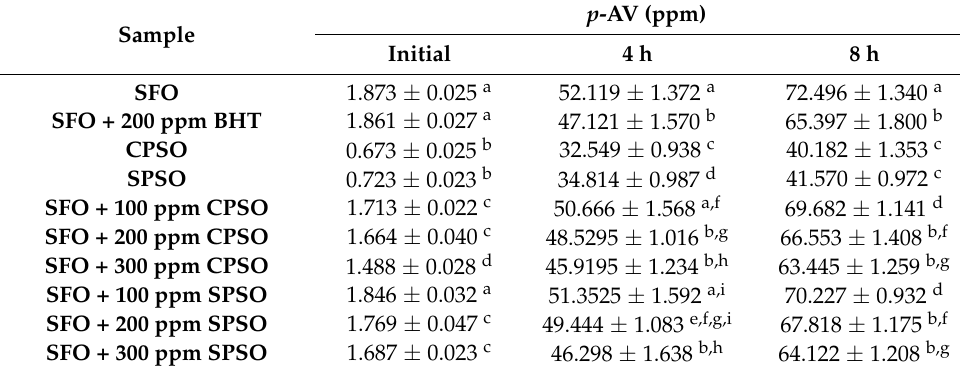
Table 5. The p -AV of oil samples in response to heat